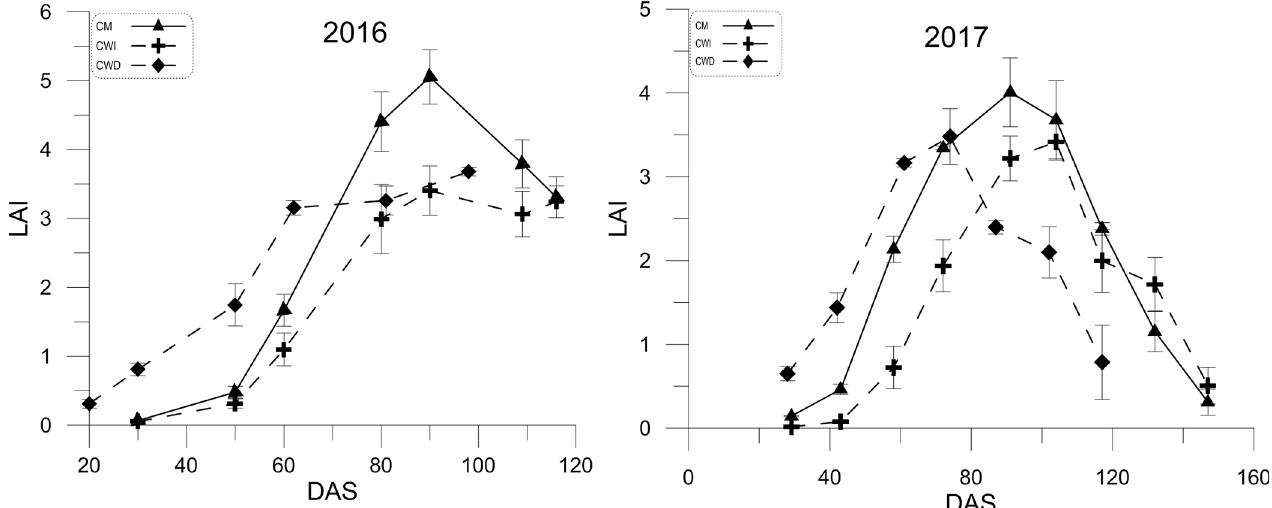
Fig 6. The LAI in terms of DAS of the different planting patterns in 2016 and 2017. Note: The error bars represent the standard deviations (STDEVs) (n = 3).